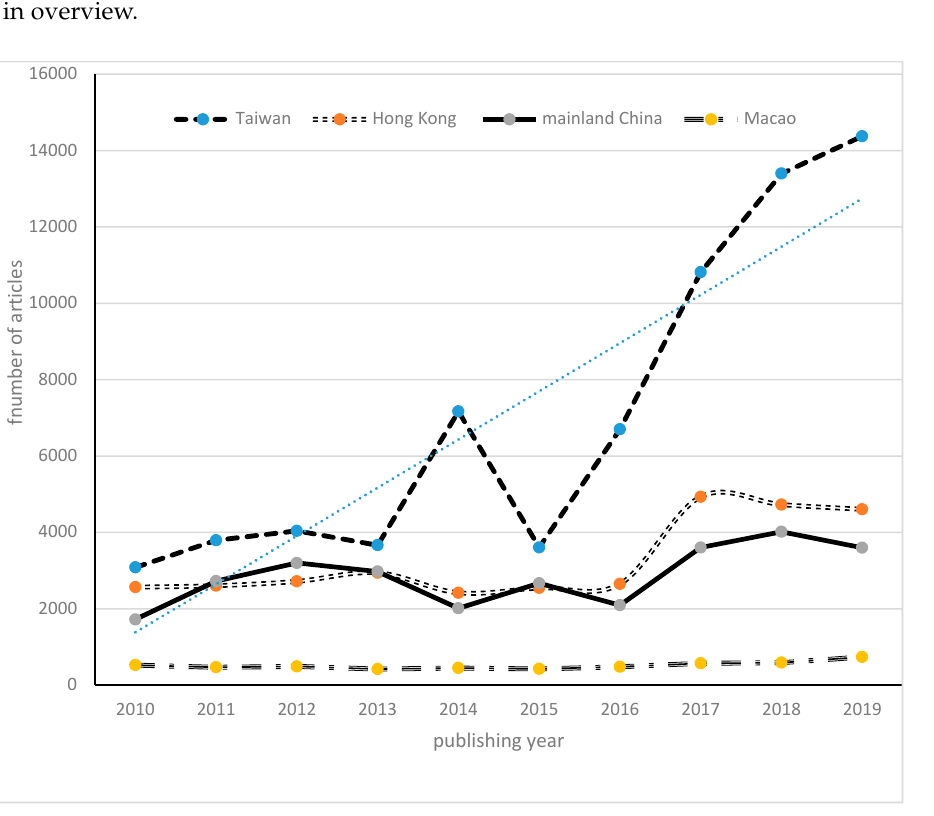
Figure 1. Number of non-communicable disease (NCD)-related articles in Chinese newspapers in mainland China and three neighboring areas, 2010–2019.